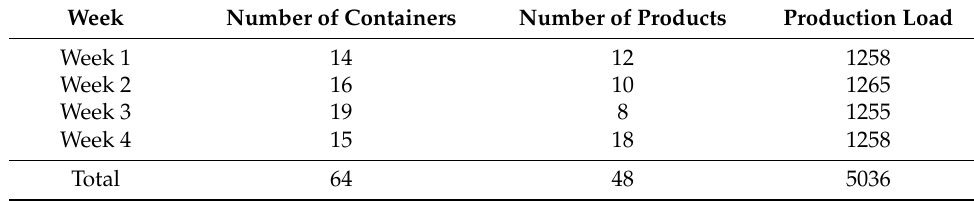
Table 1. Summary of the decision variables for Case 1.